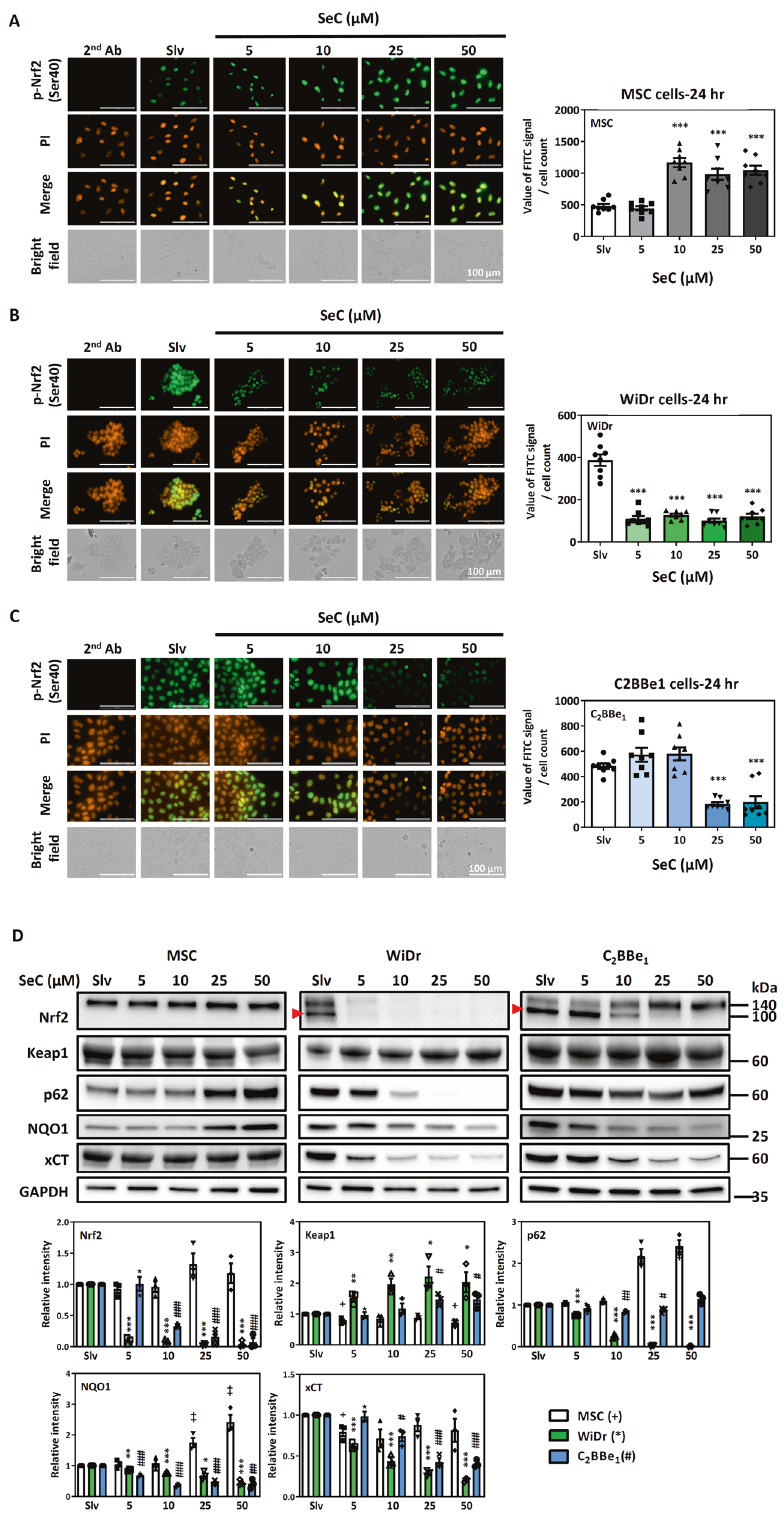
Fig. 2 SeC inhibited nuclear translocation of Nrf2 and downstream proteins in Nrf2-addicted cells. A – C Translocation of phosphorylated Nrf2 into the nucleus in non – Nrf2-addicted MSCs ( A ) and WiDr ( B ) and C 2 BBe 1 ( C ) cells. The cell count in fi eld was determined using Image J. The fl uorescence intensity was normalized with cell number from eight fi eld. All quanti fi ed results are express as mean ± SD. (* P < 0.05, ** P < 0.01, *** P < 0.001, compared with solvent control for each cell type). D Protein levels of NRF2, Keap1, p62, NQO1, and xCT in MSCs and WiDr and C 2 BBe 1 cells after 24 h of SeC treatment. Relative levels of these target proteins were normalized to GAPDH (loading control. The values were presented as average ± SD from three independent repeats. (* and + P < 0.05, ** and ++ P < 0.01, * ** and +++ P < 0.001, n = 3, compared with solvent control for each cell type). Signi fi cance was determined by an unpaired t test.